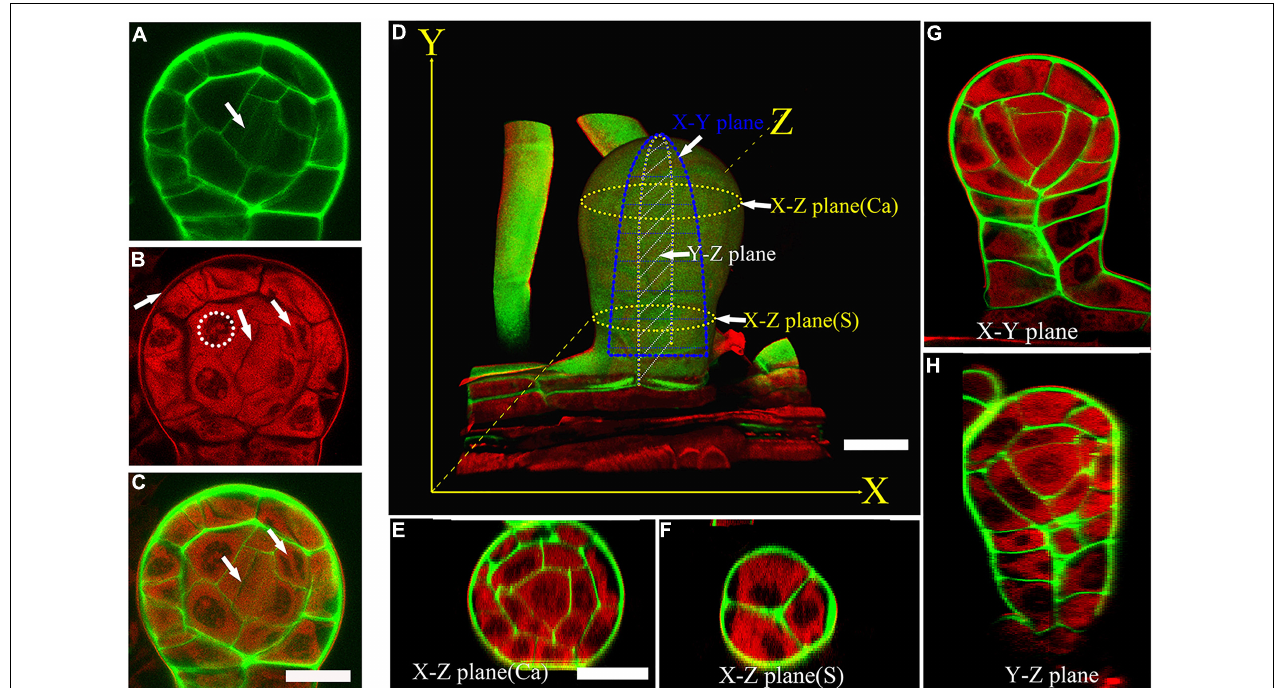
FIGURE 1 | A co-staining method for the cell lineages and sporangium development. (A) CW staining of a sporangium. CW signals are colored green. Arrow points to the newly formed cell wall. (A–C) are at the same magnification. (B) BF staining of a sporangium. BF signals are colored red. Dotted circle points to the uncolored nuclear. The middle arrow points to the cytokinesis. The left arrow points to the outer wall of epidermal cells. The right arrow points to the nuclear division. (C) Merged image of (A,B) . The left arrow points to the newly formed cell wall. The right arrow points to the nuclear division. Scale bar = 20 µ m. (D) 3D imaging of a sporangium. CW signals are colored green. BF signals are colored red. Scale bar = 20 µ m. (E) X-Z plane of a capsule. Scale bar = 20 µ m. (E–H) are at the same magnification. (F–H) X-Z plane of the stalk cells, X-Y plane of the sporangium, Y-Z plane of the sporangium. CW signals are colored green. BF signals are colored red. Ca, capsule; S, stalk